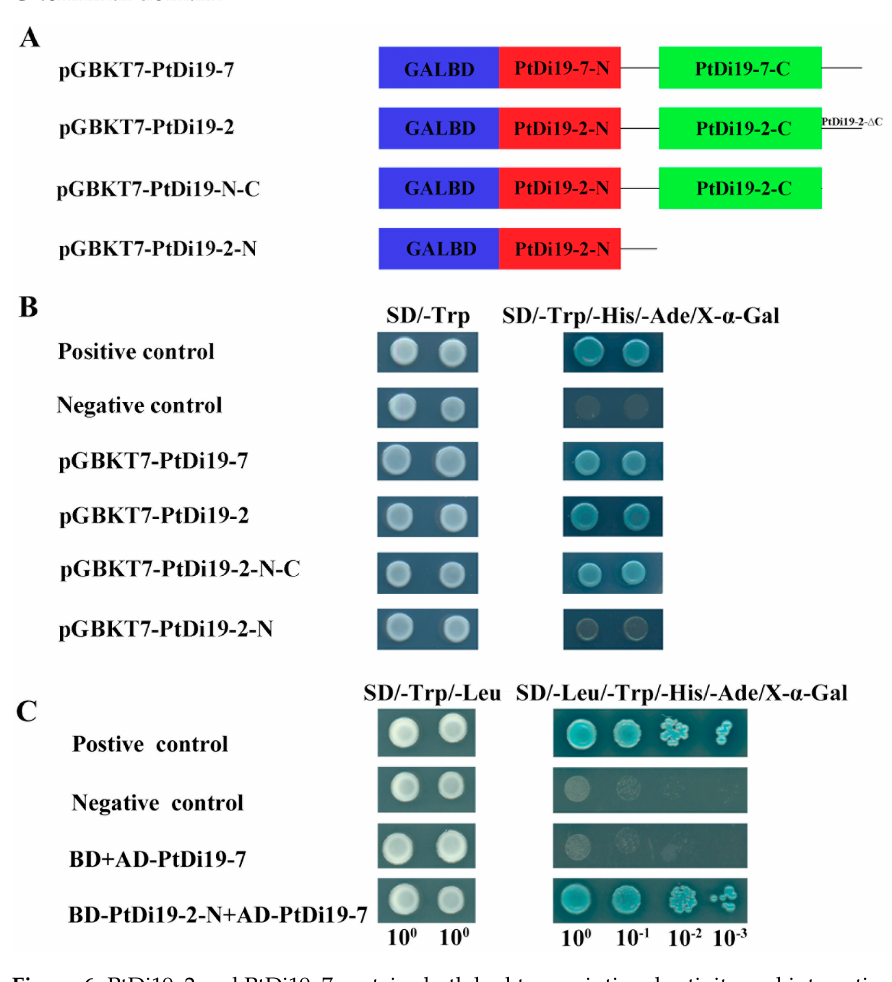
Figure 6. PtDi19–2 and PtDi19–7 proteins both had transcriptional activity and interaction with